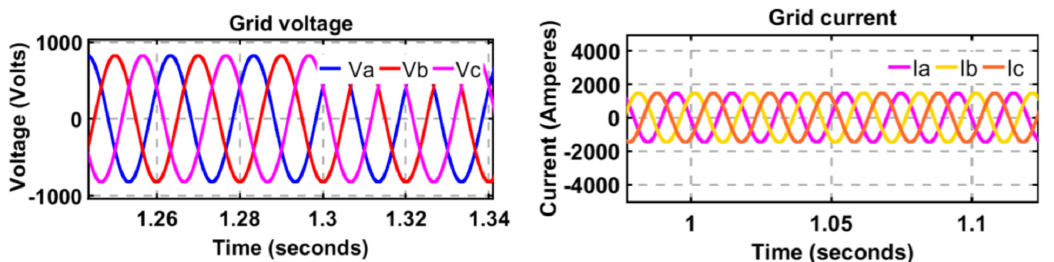
Figure 11. ( a ) Load active and reactive power, ( b ) grid active and reactive power, ( c ) load voltage, ( d ) load current, ( e ) grid voltage, and ( f ) grid